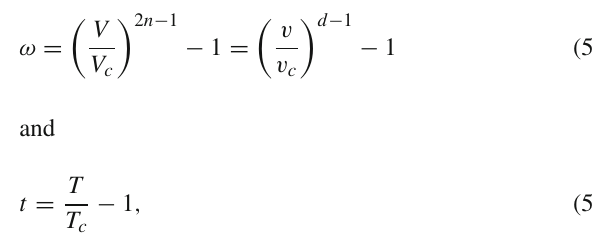
Fig. 6 Gibbs free energy (vertical axis) v/s T (horizontal axis) for n = 3 and d = 10 with Q = 1